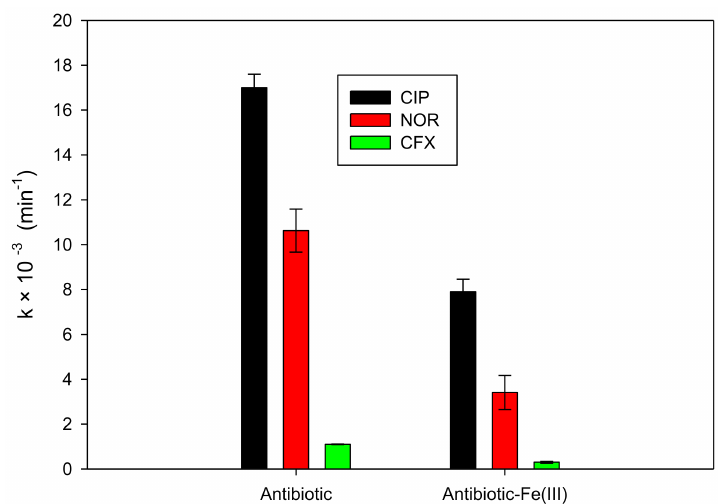
Figure 1. Pseudo-first order rate constants (k) for the degradation of antibiotics and their ferric complexes under simulated solar light. Experimental conditions: [Antibiotic]: at the stoichiometric ratio with Fe (III), [Fe (III)]: 2.5 µ mol L − 1 , pH initial 6.0. Note: DCX, CLX, and their ferric complexes had no photodegradation; i.e., the k values were zero.